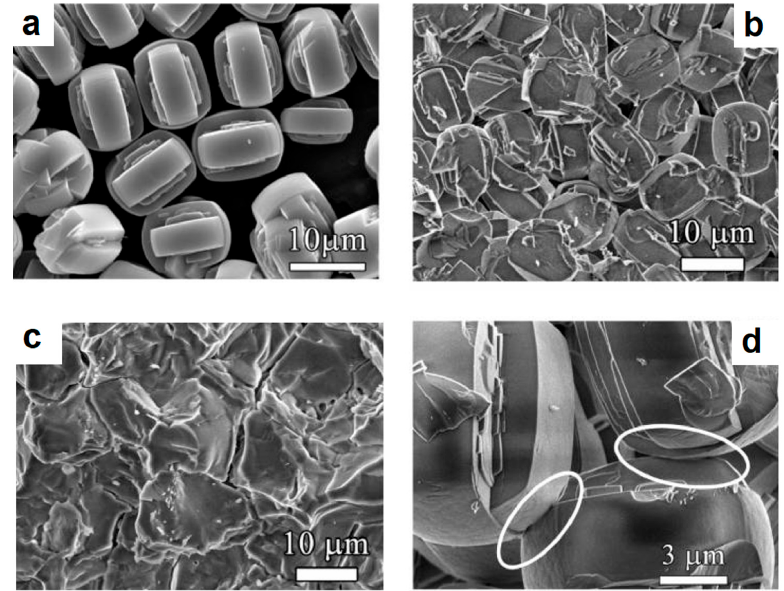
Figure 8. Morphology of silicalite-1 particles ( a ), fracture surface of compacts produces by SPS at 1100 ◦ C ( b , d —different magnifications) and 1300 ◦ C ( c ). Reprinted from Vasiliev et al. [63], Copyright 1100 °C ( b , d– different magnifications) and 1300 °C ( c ). Reprinted from Vasiliev et al. [63], Copyright (2010) with permission from the American Chemical (2010) with permission from the American Chemical Society.